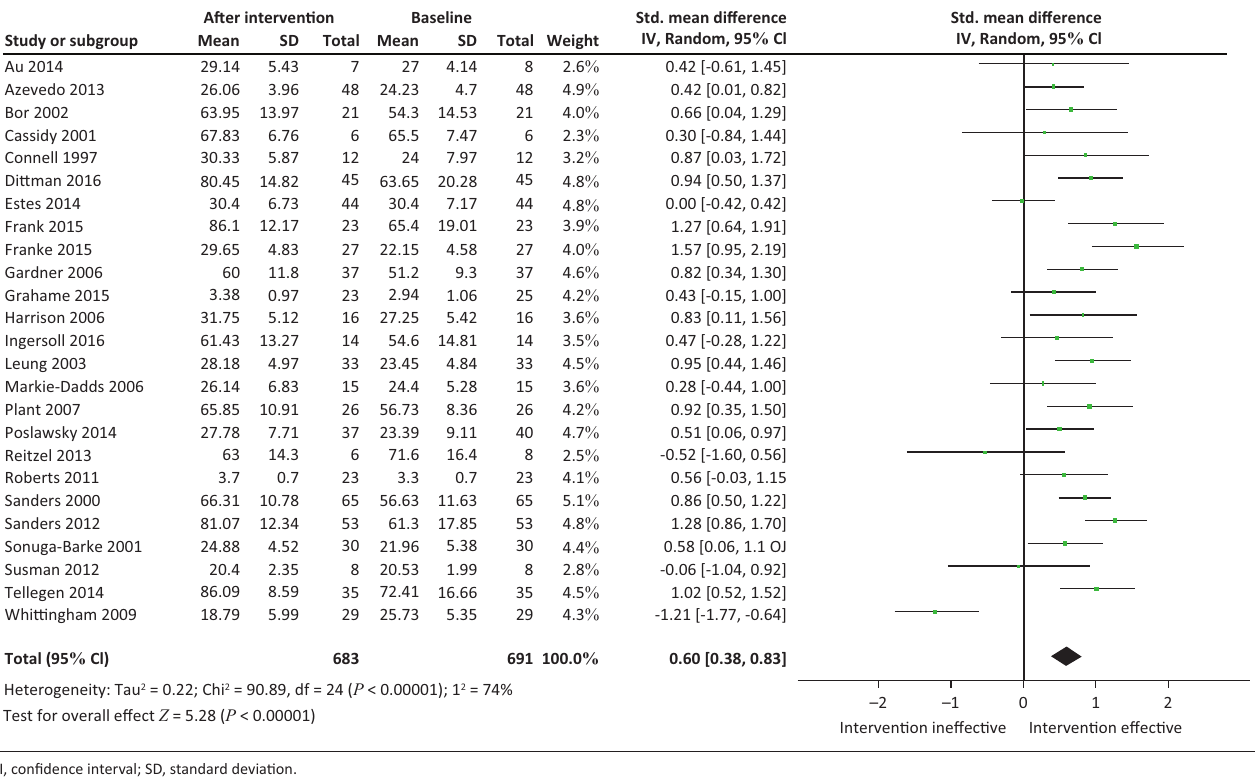
FIGURE 3: Random effects meta-analysis of the summative effects of parent training programmes on parental self-efficacy levels. TABLE 2: Summative parental self-efficacy outcomes and the subgroup analyses. Subgroups analysed k